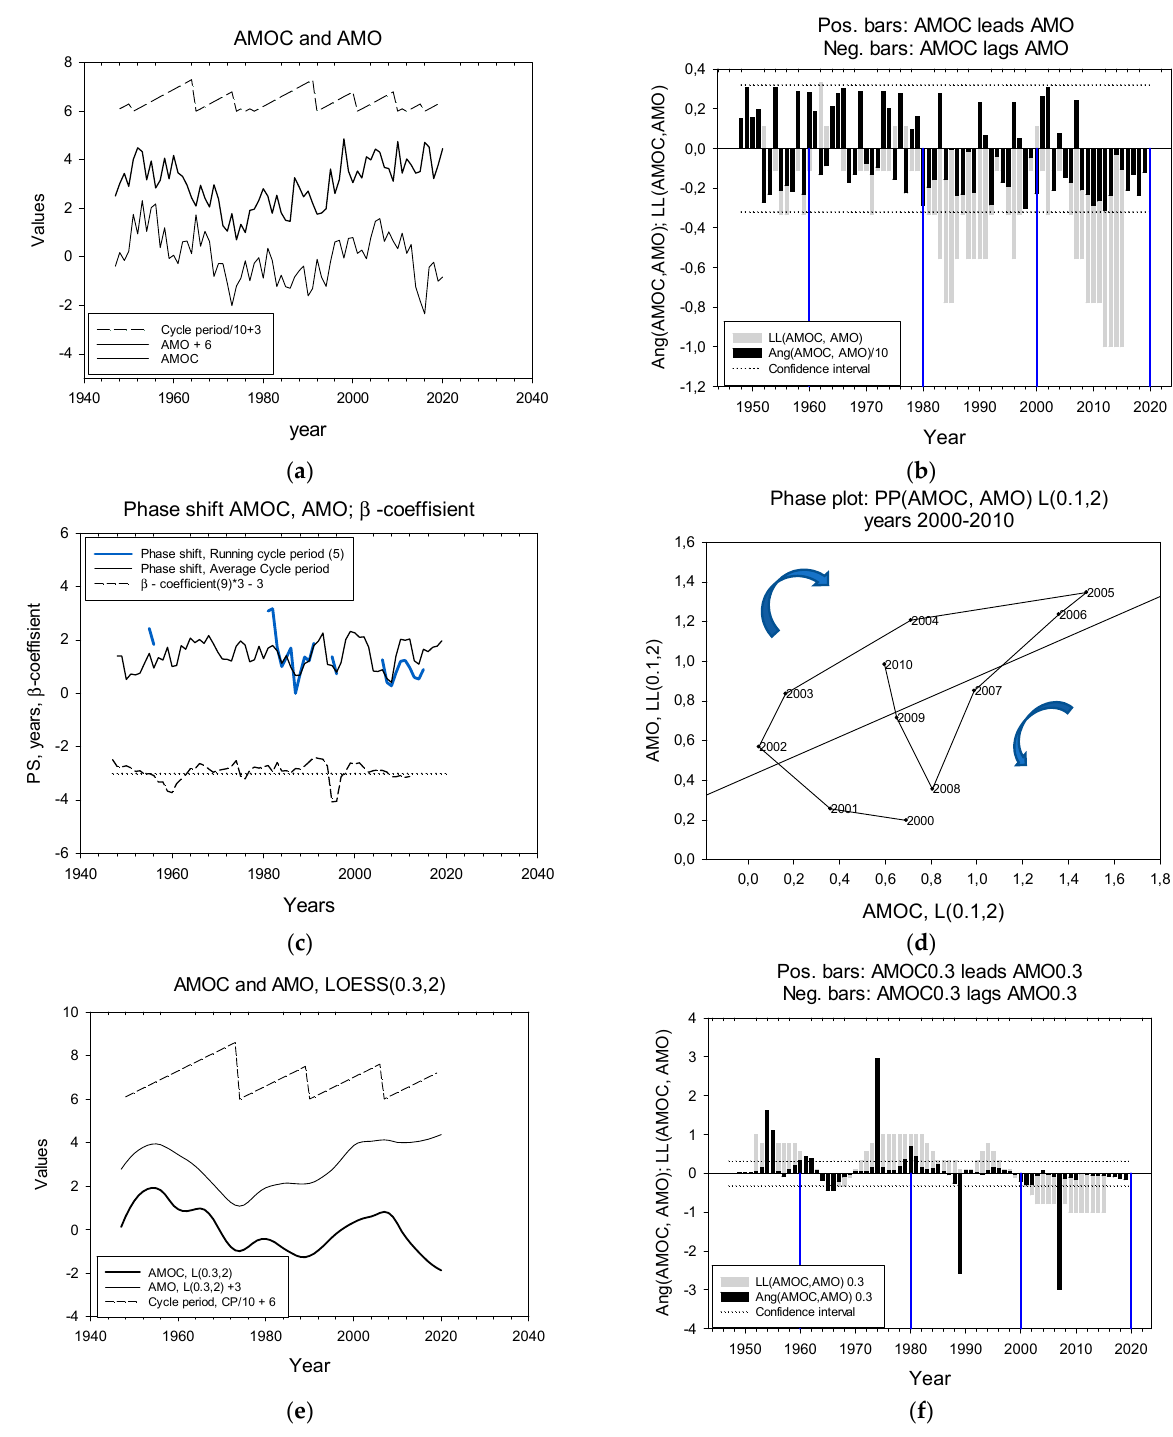
Figure 3. LL relations for AMOC and AMO. ( a ) Time series raw. The upper zigzag curve shows cycle periods. ( b ) LL relations between AMOC and AMO. Black bars show angles, θ (3), calculated over three consecutive observations; grey bars show the sign of angles, LL(9) calculated over 9 years. Dashed lines show confidence interval. Droplines designate time windows of 20 years starting at 1960. ( c ) Phase shift calculated with two methods and the β -coefficient for the two series. ( d ) Phase plot for the two series with AMOC and AMO slightly LOESS(0.1)-smoothed on the x- and y-axis, respectively. ( e ) The two series LOESS(0.3)-smoothed and their cycle periods. ( f ) LL relations between the two series. Black bars for θ (3), and grey bars for